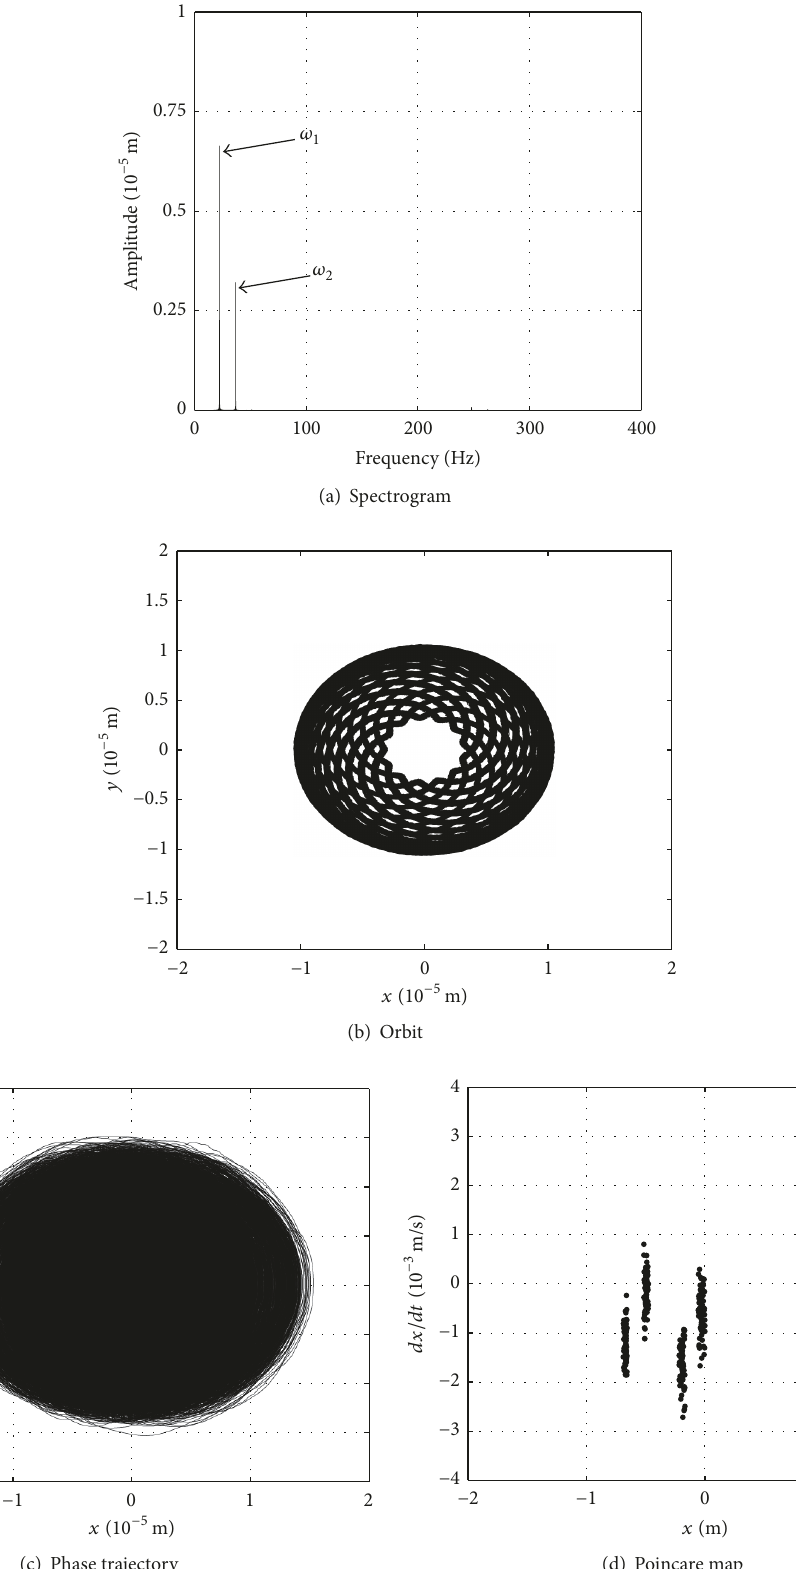
Figure 15: Response analysis of disk 2: 𝜔 1 = 140 rad / s and 𝜆 = 1.65